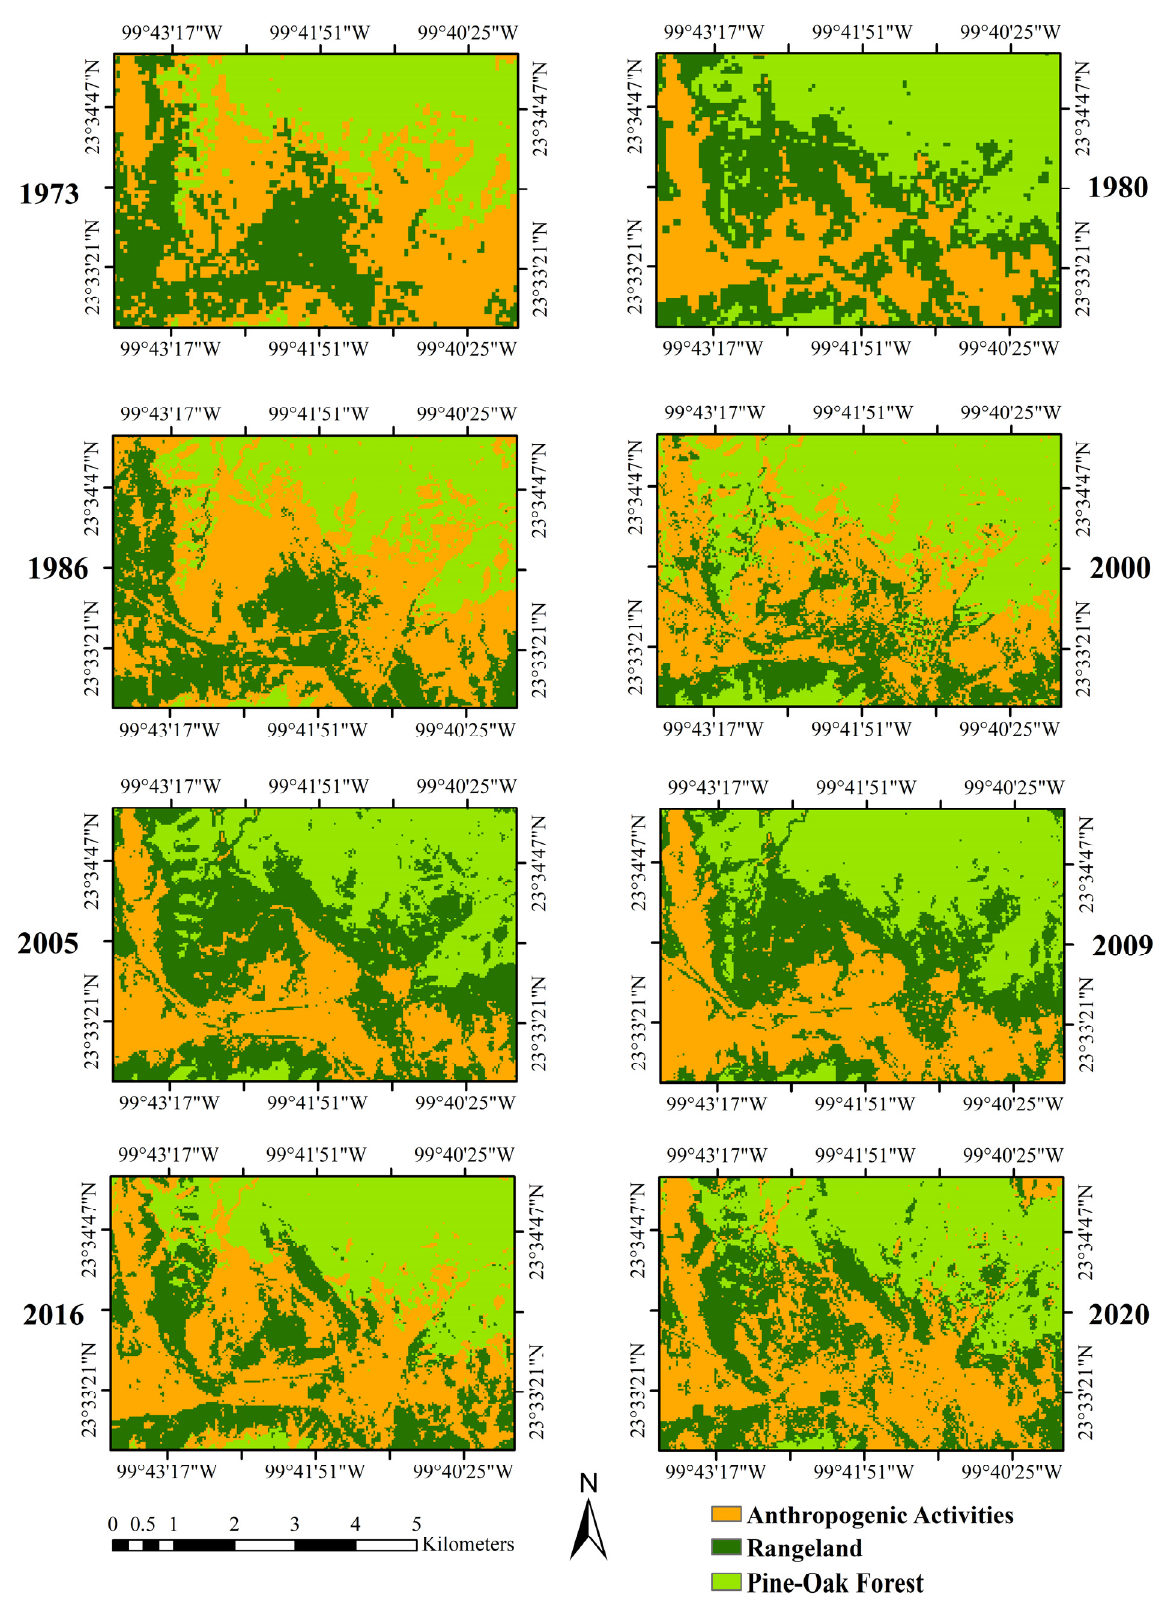
Figure A3. Land use coverage in 1973, 1980, 1986, 2000, 2005, 2009, 2016, and 2020, La